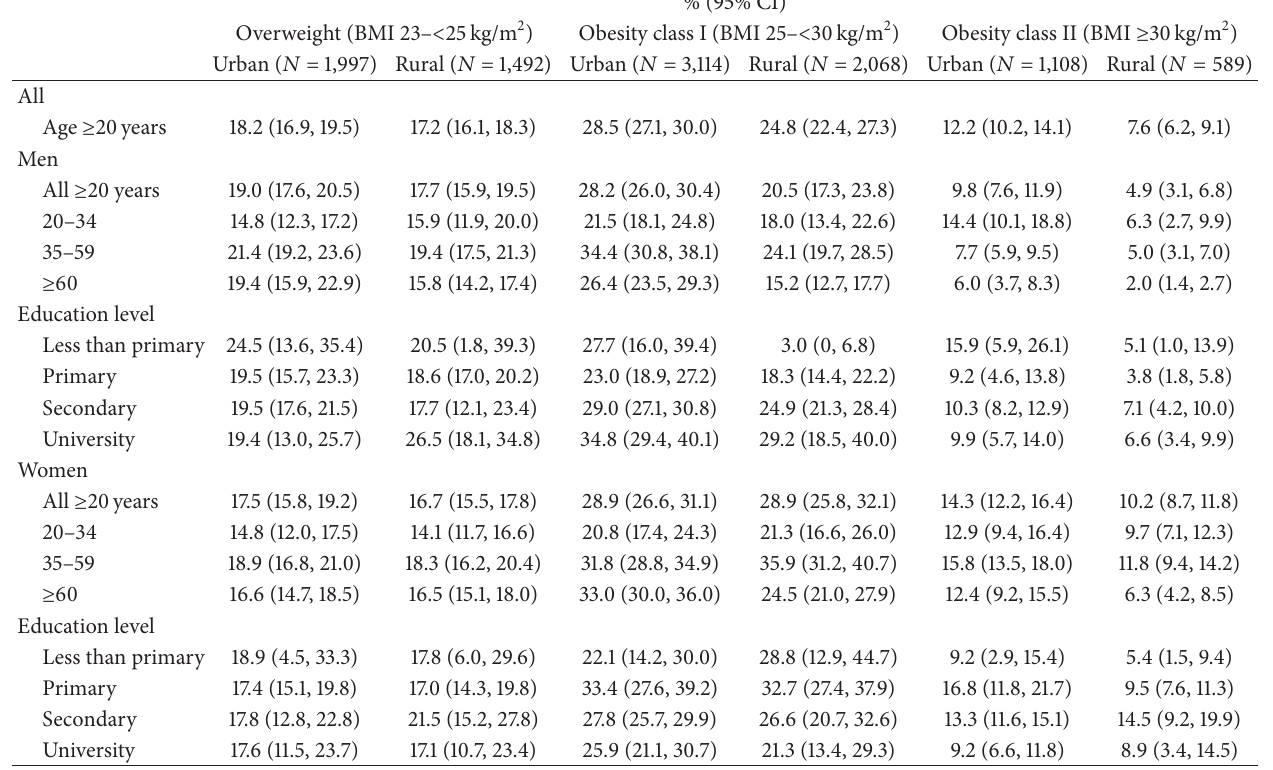
Table 1: Age-specific prevalence and age-adjusted prevalence of overweight and obesity in Thai population aged ≥ 20years, in 2009.